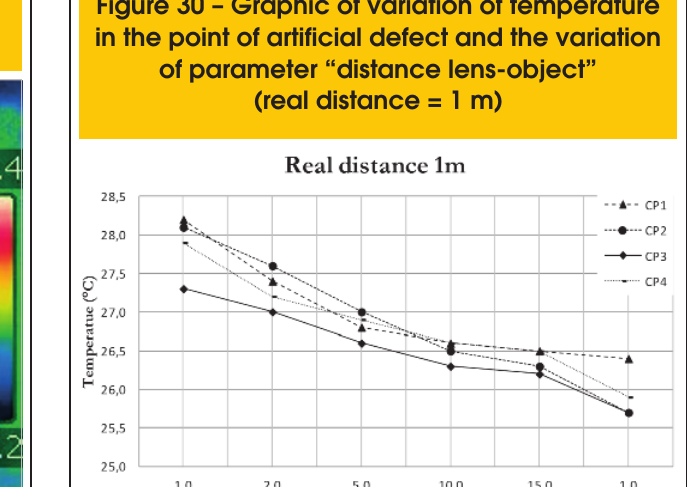
Figure 30 – Graphic of variation of temperature in the point of artificial defect and the variation of parameter “distance lens-object” (real distance = 1 m)